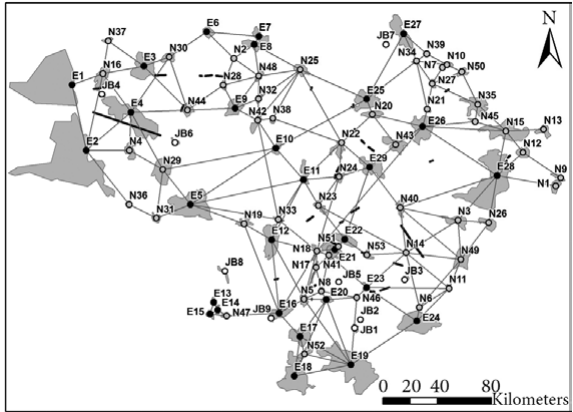
Fig. 4. Input data prepared based on ecologically compensating infrastructure